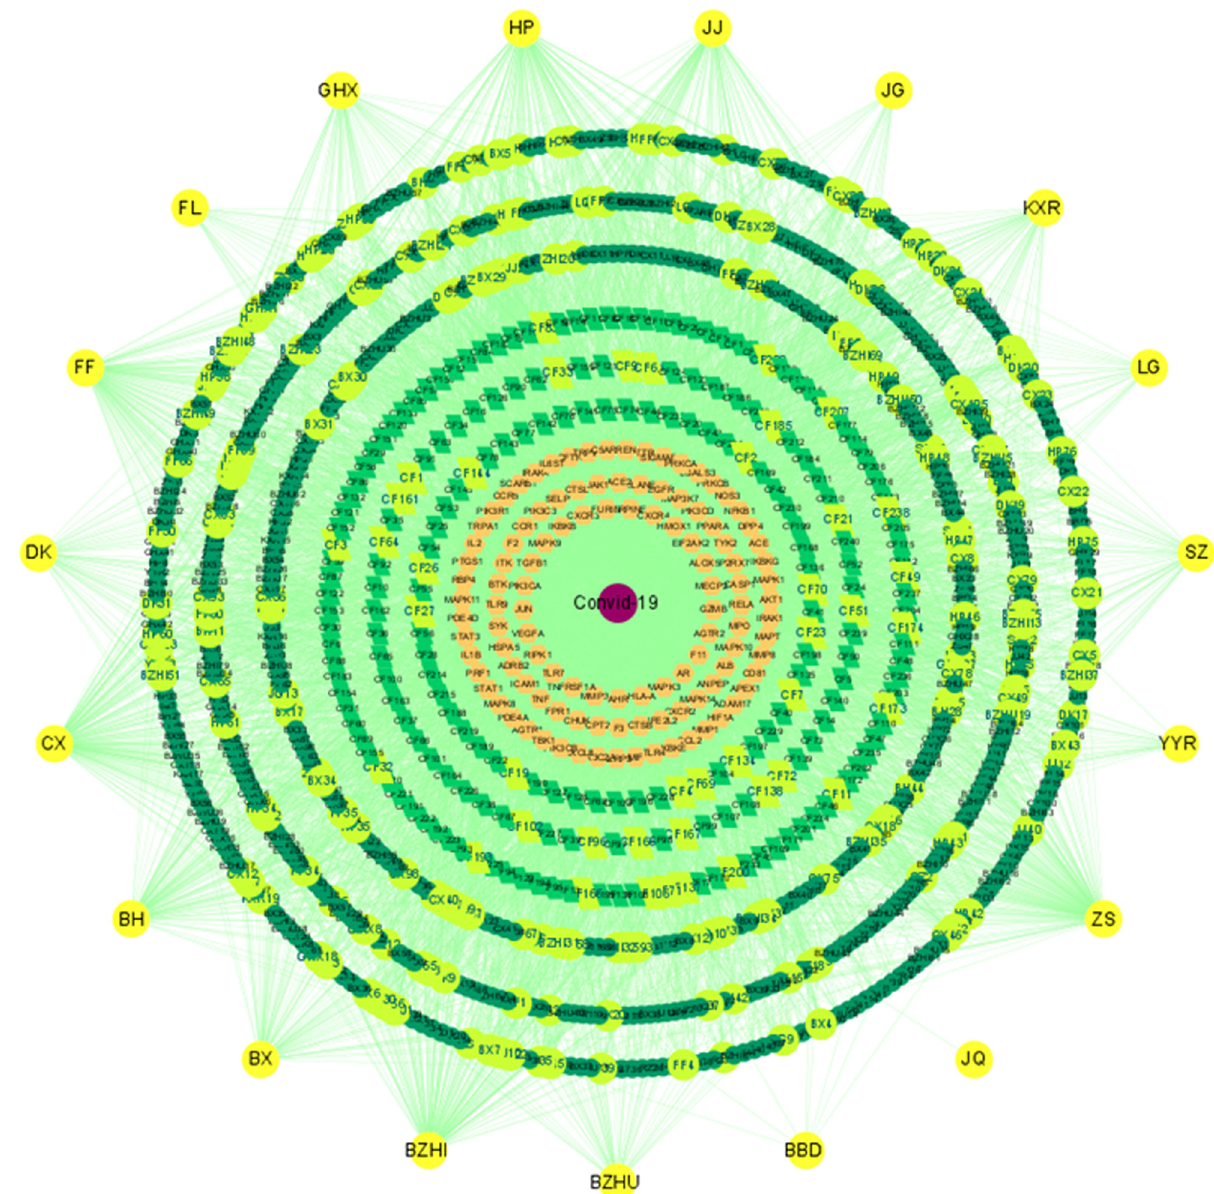
Figure 1: The Herb – Compound – Target – Disease network. Yellow circles are drugs of Xinguan No. 3. Green circles are the active components. Light green circles are the duplicate components. Orange circles are intersection